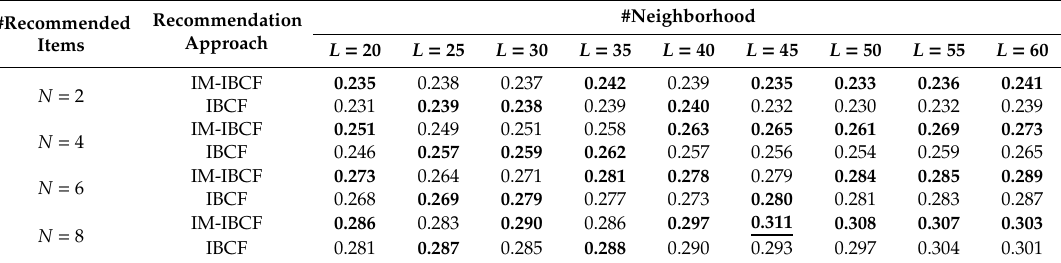
Table 7. Results of recall measure on the MovieLens 100K